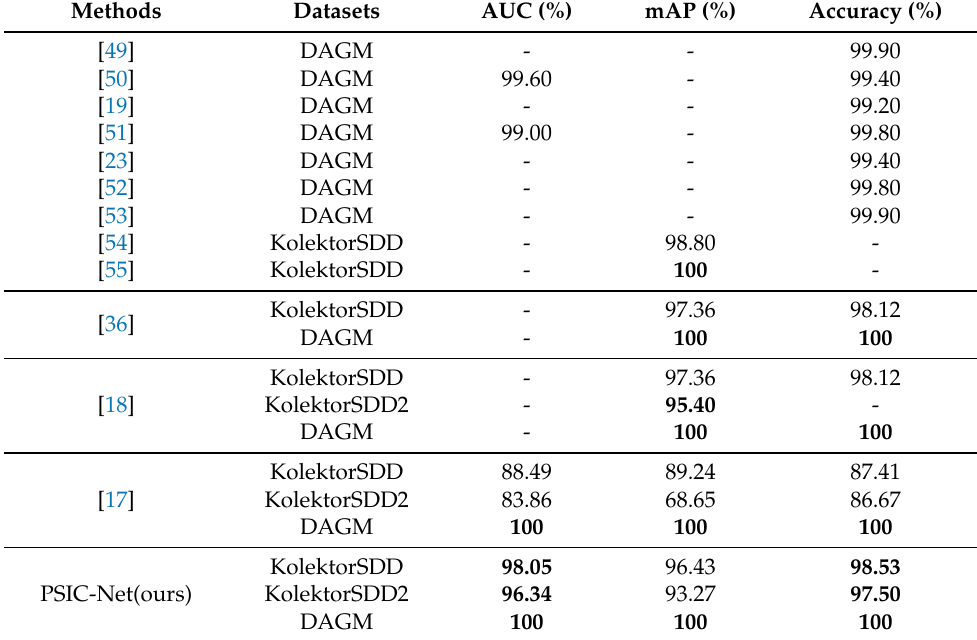
Table 4. Comparison of classification effects of various methods and